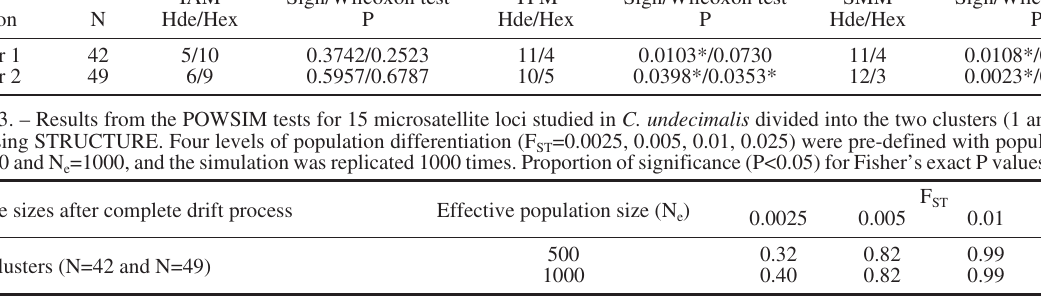
Table 2. – Results from the BOTTLENECK tests for 15 microsatellite loci studied in C. undecimalis divided into the two clusters (1 and 2) identified using STRUCTURE. Sign and Wilcoxon tests for excess heterozygosity: N, number of individuals analysed; Hde, number of loci showing a heterozygosity deficiency; Hex, number of loci showing excess heterozygosity. IAM, Infinite-Allele Model, TPM, Two-Phase Model (90% SMM), SMM, Stepwise-Mutation Model, * significant values from the sign/Wilcoxon test (P ≤ 0.05).